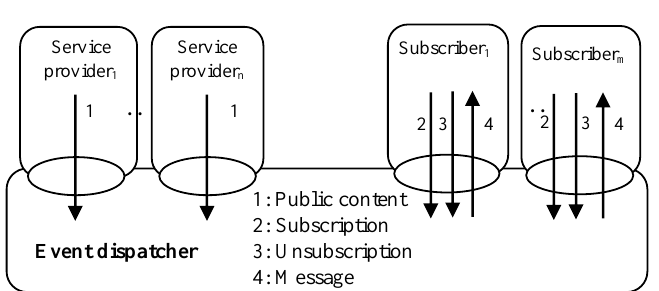
Figure 1. Service based routing